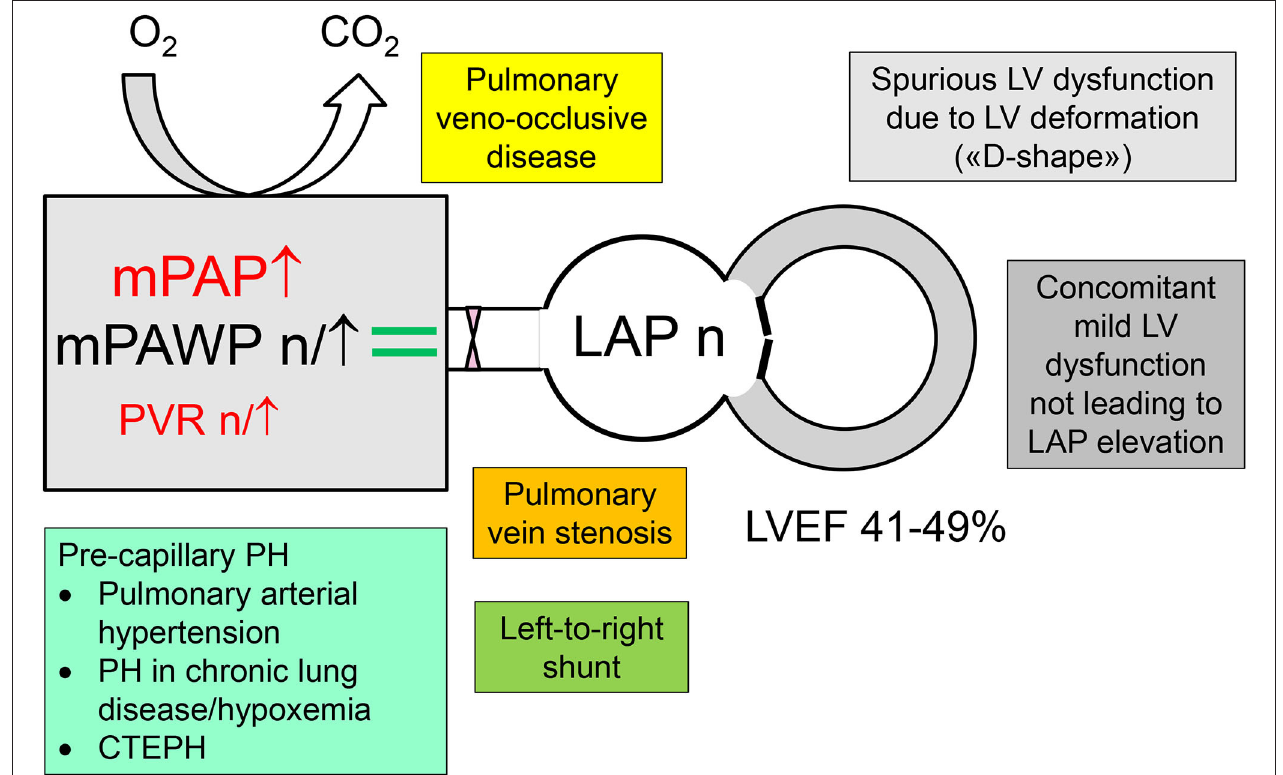
FIGURE 2 | Differential diagnosis of pulmonary hypertension (PH) in patients with a left ventricular ejection (LVEF) in the mid-range of 41–49% but normal left atrial pressure (LAP), i.e., non-group 2 PH. CTEPH, chronic thromboembolic pulmonary hypertension; mPAP, mean pulmonary artery pressure; mPAWP, mean pulmonary artery wedge pressure; PVR, pulmonary vascular